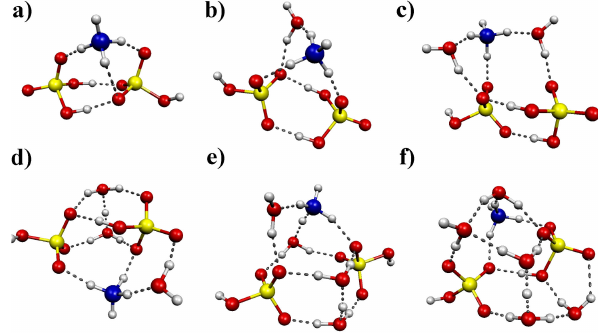
Fig. 5. The most stable structures with respect to the forma- tion free energy 1G (at T = 298 . 15K and P = 1atm) for clus- ters consisting of two sulfuric acids with ammonia and 0–5 water molecules: (a) ( H 2 SO 4 ) 2 · NH 3 , (b) ( H 2 SO 4 ) 2 · NH 3 · H 2 O, (c) ( H 2 SO 4 ) 2 · NH 3 · ( H 2 O ) 2 , (d) ( H 2 SO 4 ) 2 · NH 3 · ( H 2 O ) 3 , (e) ( H 2 SO 4 ) 2 · NH 3 · ( H 2 O ) 4 , (f) ( H 2 SO 4 ) 2 · NH 3 · ( H 2 O ) 5